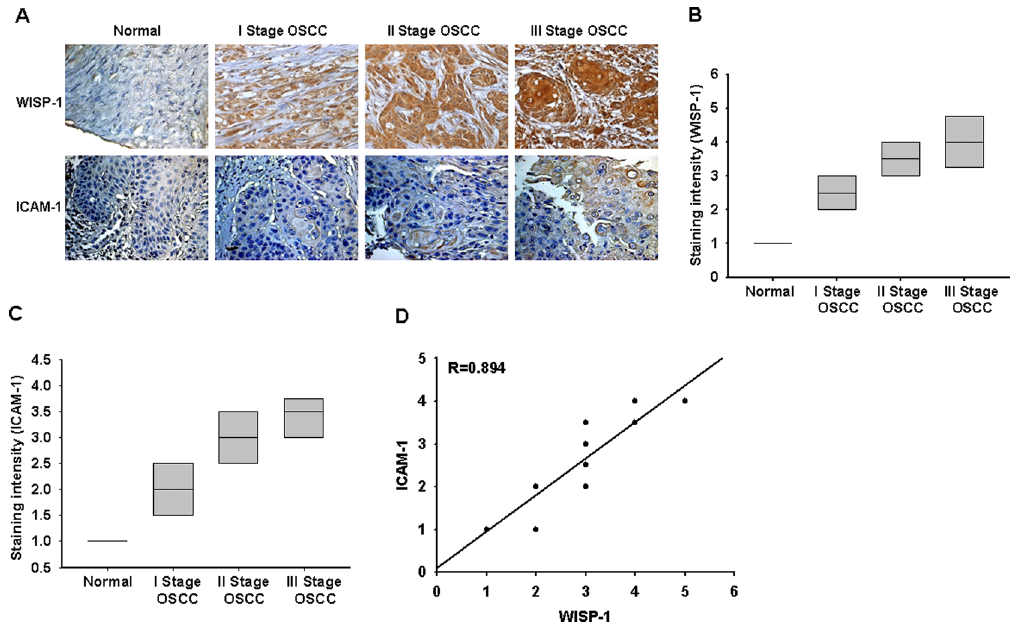
Figure 6. WISP-1 and ICAM-1 expression correlates with the tumor stage of patients with OSCC. Immunohistochemistry of WISP-1 (A&B) and ICAM-1 (A&C) expression in normal and OSCC tissue. The correlation and quantitative data are shown in